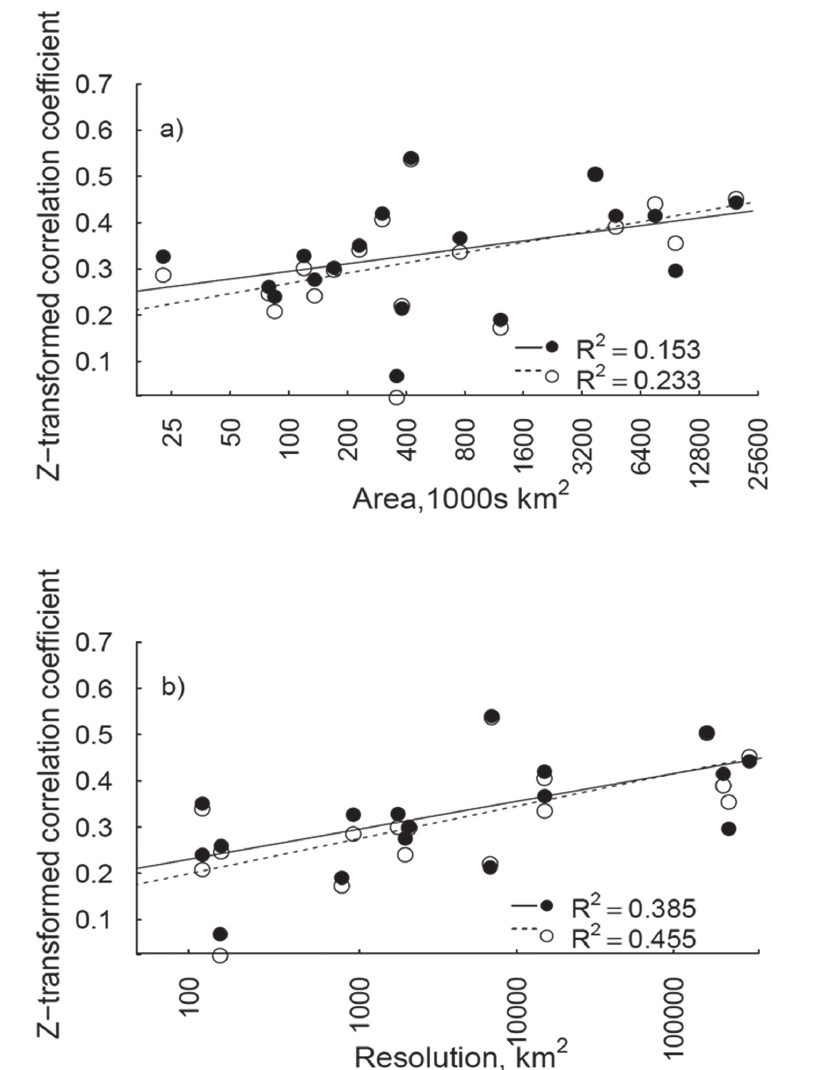
Figure s3. Relationships between the correlation strength (Z-transformed Spearman’s ρ coefficient) of GCW-derived invasiveness measures (using ‘weed only references in the Global Compendium of Weeds) versus regional distributions, and region area ( a ) and resolution (area of distribution units; b ). Solid lines and circles represent the fitted models and correlation strengths per region, respectively, with number of references in the global compendium of weeds as the GCW-invasiveness measure. Dashed lines and open circles are fitted models and region correlation strengths, respectively, with the number of GCW areas as the invasiveness measure. Note the natural log scale on the x